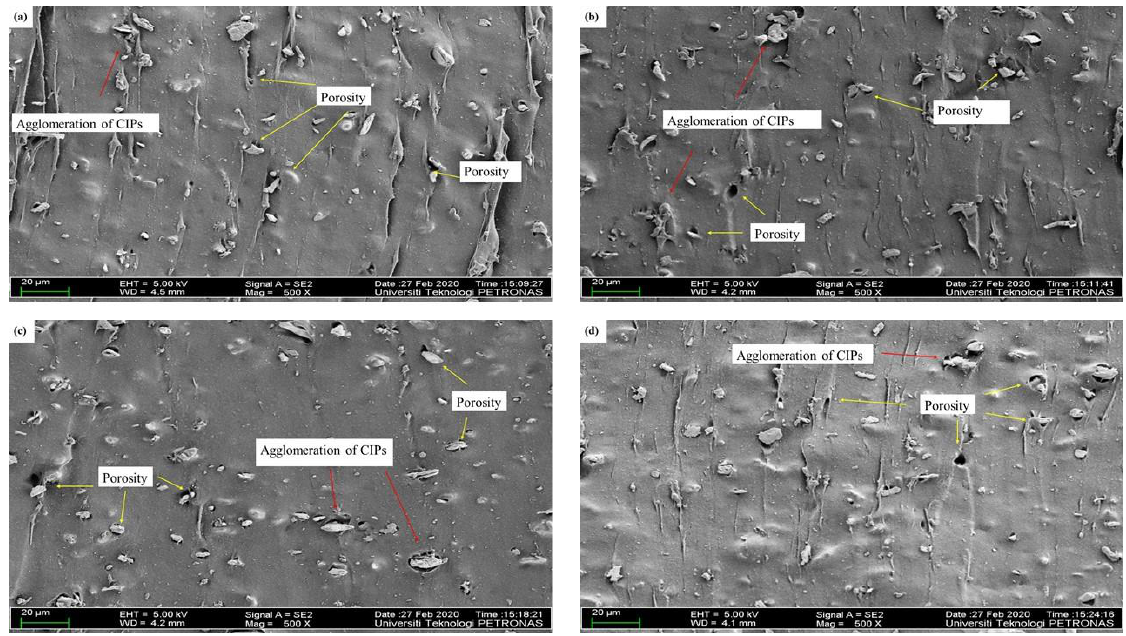
Figure 4. Microstructures of MREs for different ratios of NO:AO. ( a ) NO 1, ( b ) NO 2, ( c ) NO 3, and ( d ) NO 4.